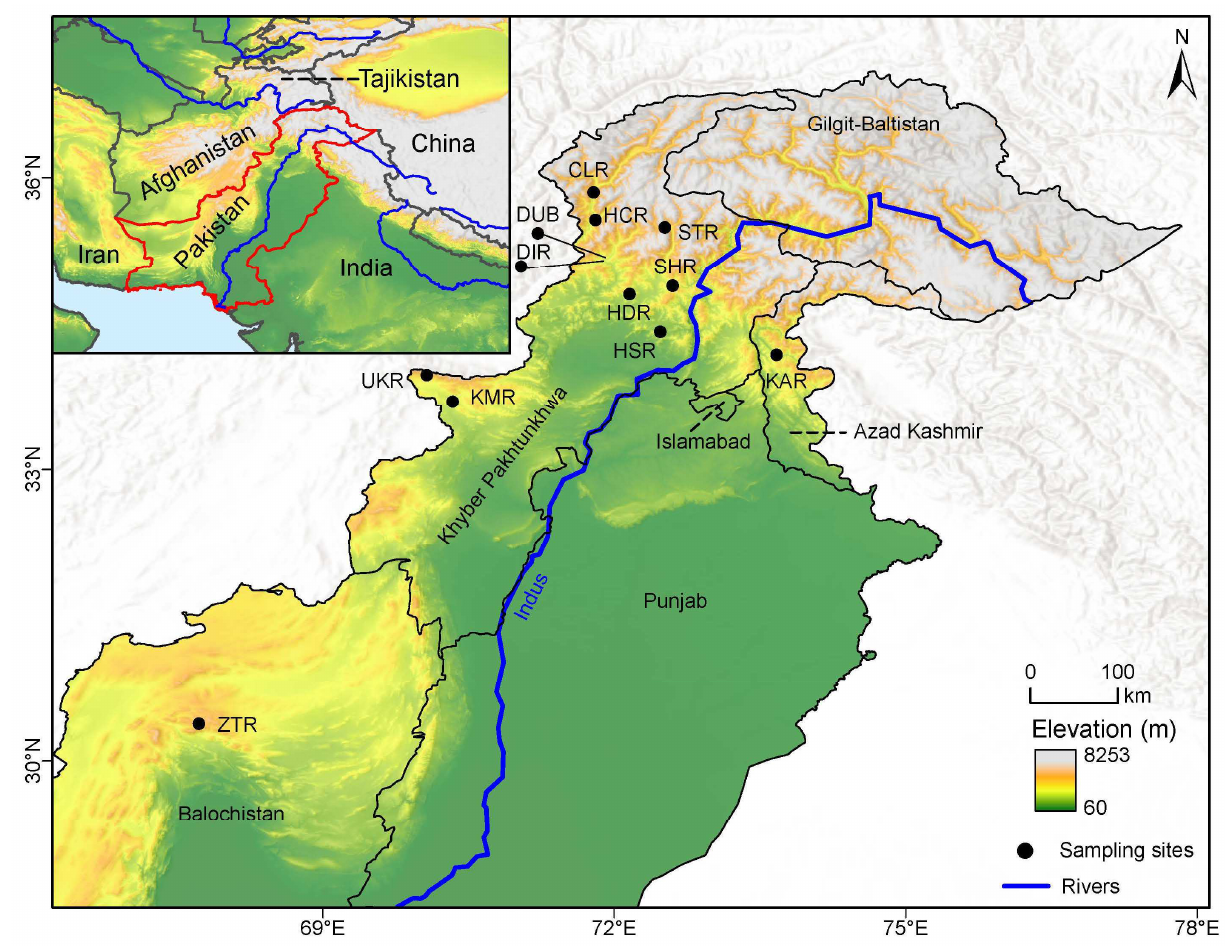
Figure 1. Sampling map of the 12 populations of walnut in this study. Sampling locations are indi- cated by black dots.